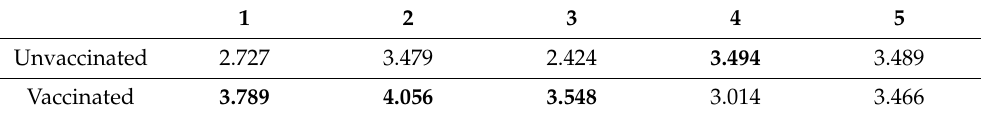
Table 4. Mean scores of variables between